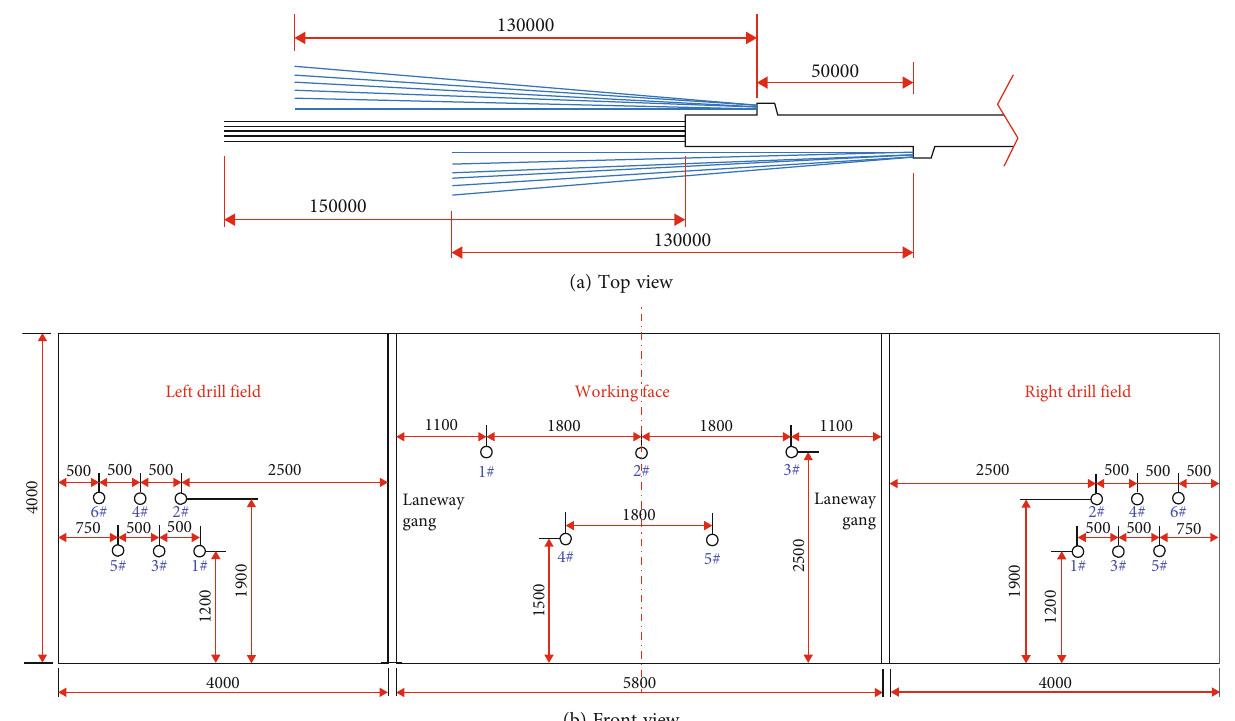
Figure 1: Schematic diagram of the layout of the 2606 haulage roadway of gas preextraction and excavating extraction